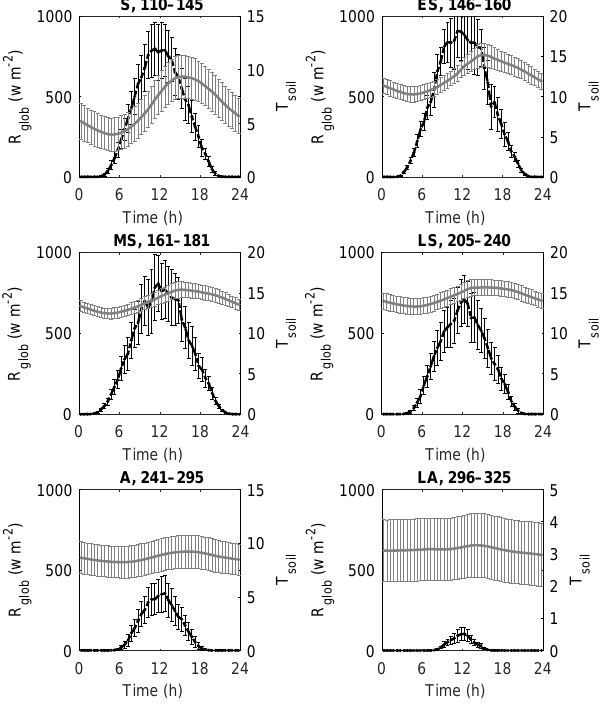
Figure 3. Diurnal cycle of half-hour mean global radiation ( R glob , Wm − 2 ; black) and soil temperature at 2.5cm depth (grey) at the reed canary grass crop from six distinct periods during the April to November 2011. The vertical bars indicate ± 1 SD of the fluxes and temperatures.